Question: Name the type of graph shown.
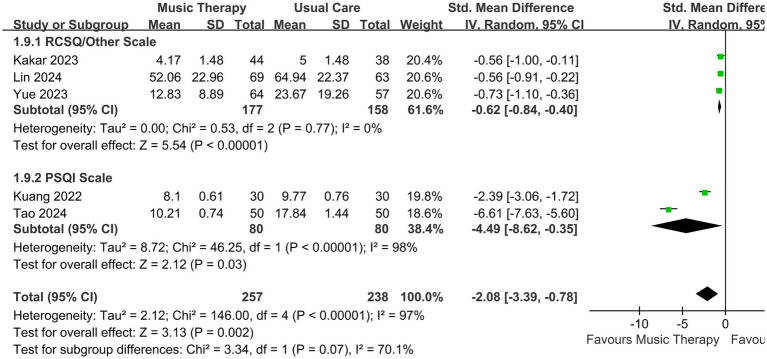
Answer: forest